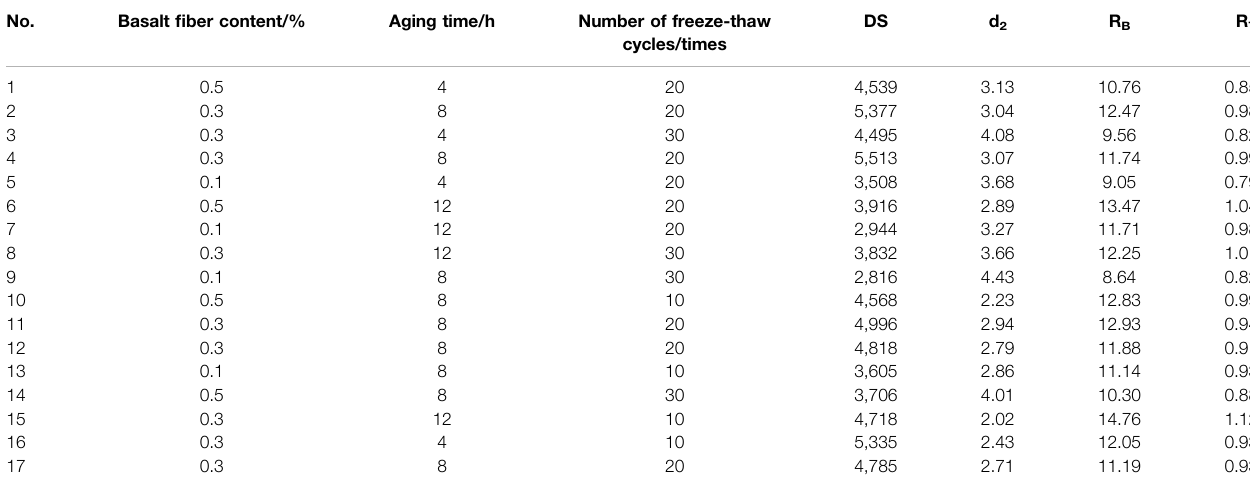
TABLE 8 | Test results of the road performance test. No. Basalt fi ber